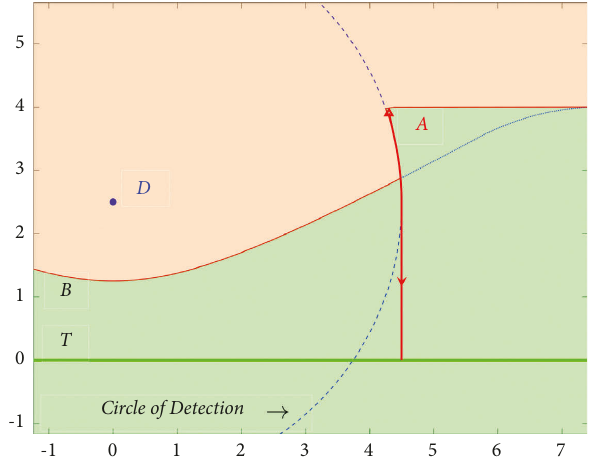
Figure 16: The numerical simulation of the barrier related to equation (65).